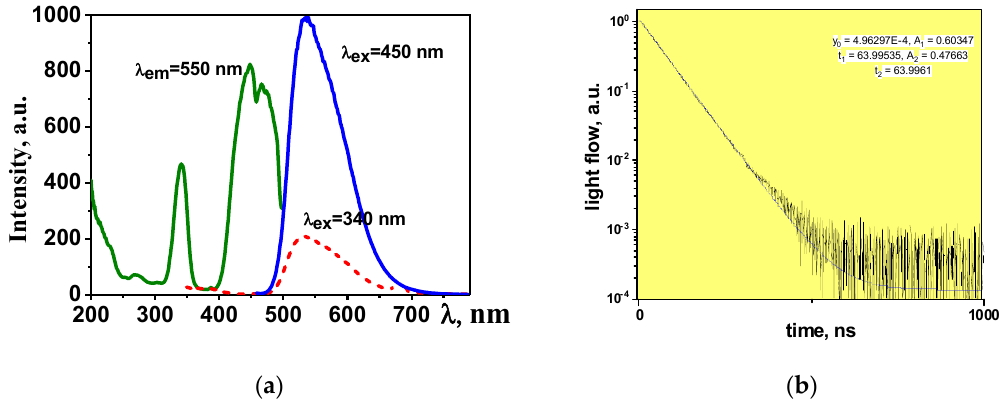
Figure 4. Excitation, luminescence ( a ), and luminescence decay kinetics spectra ( b ) of YAG:Ce